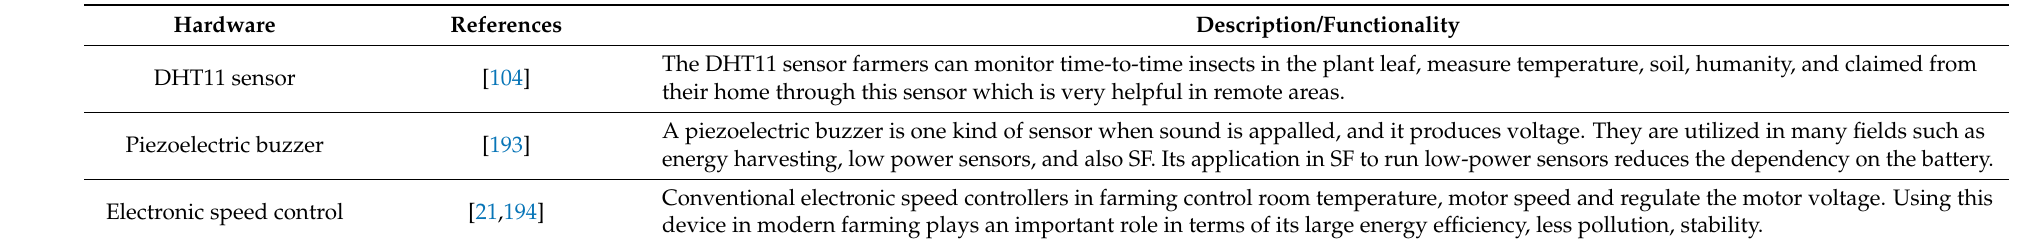
Table 6. Type of sensors in smart